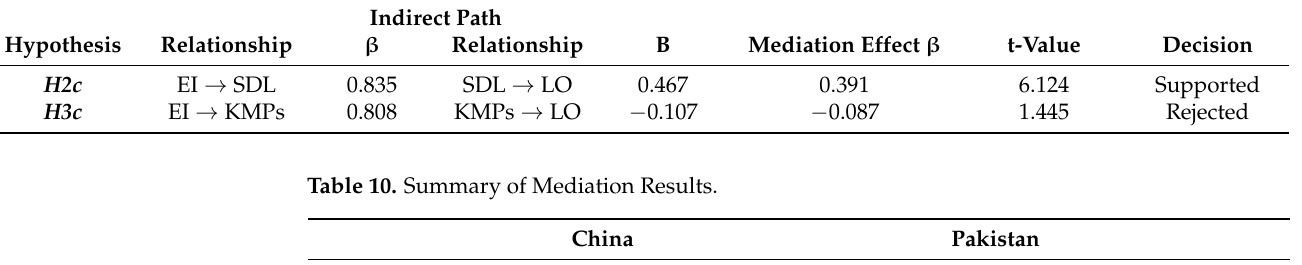
Table 9. Specific indirect effects (Pakistan sample).